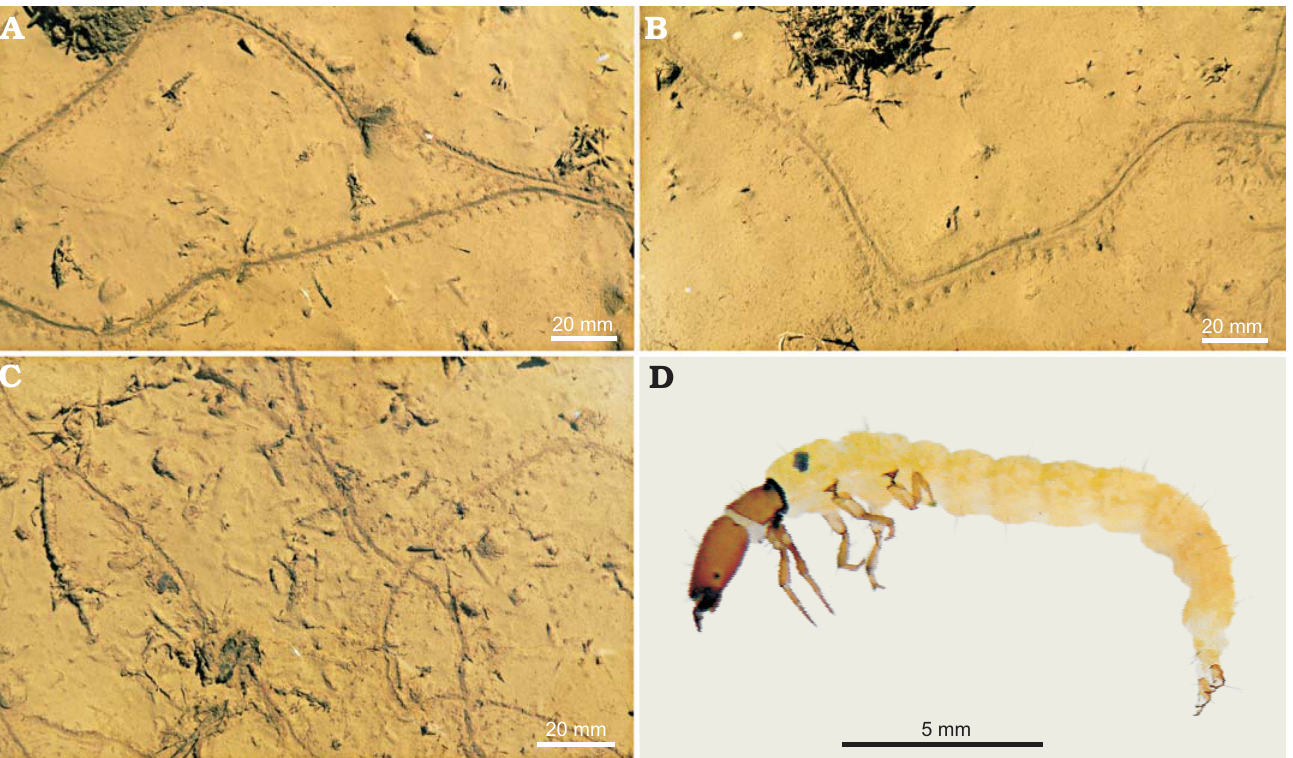
Fig. 10. Recent traces ( A–C ) of the caddisfly larvae Philopotamus montanus (Donovan, 1813) ( D ), Lejowa Valley, Tatra Mountains, southern